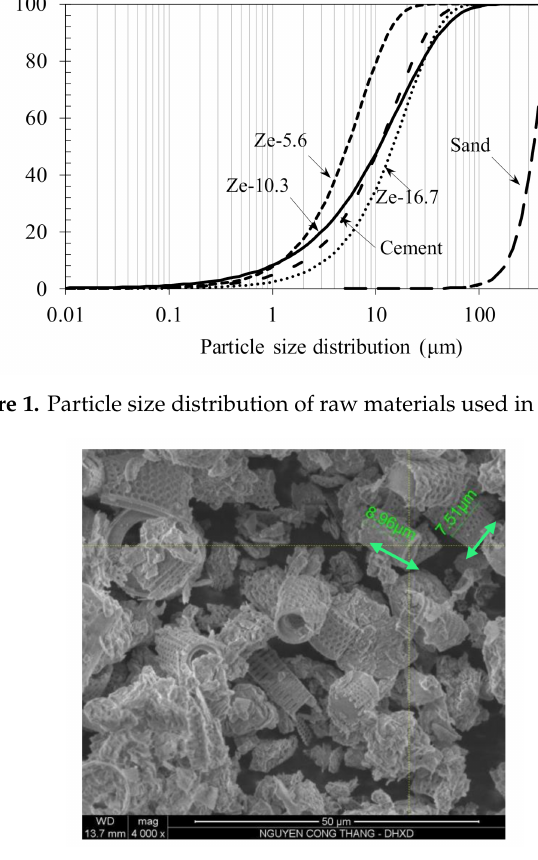
Figure 2. Scanning electron microscopy (SEM) image of zeolite